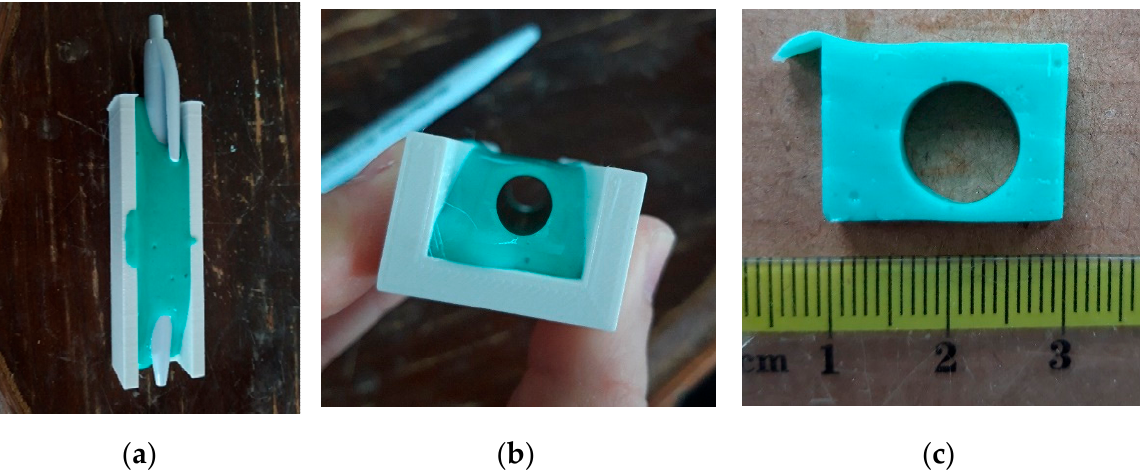
Figure 8. Pre-test. CSA of a pen: ( a ) pen in the mould filled with an alginate paste; ( b ) the CSA of the pen; ( c ) a transverse section with the ruler for the image calibration.